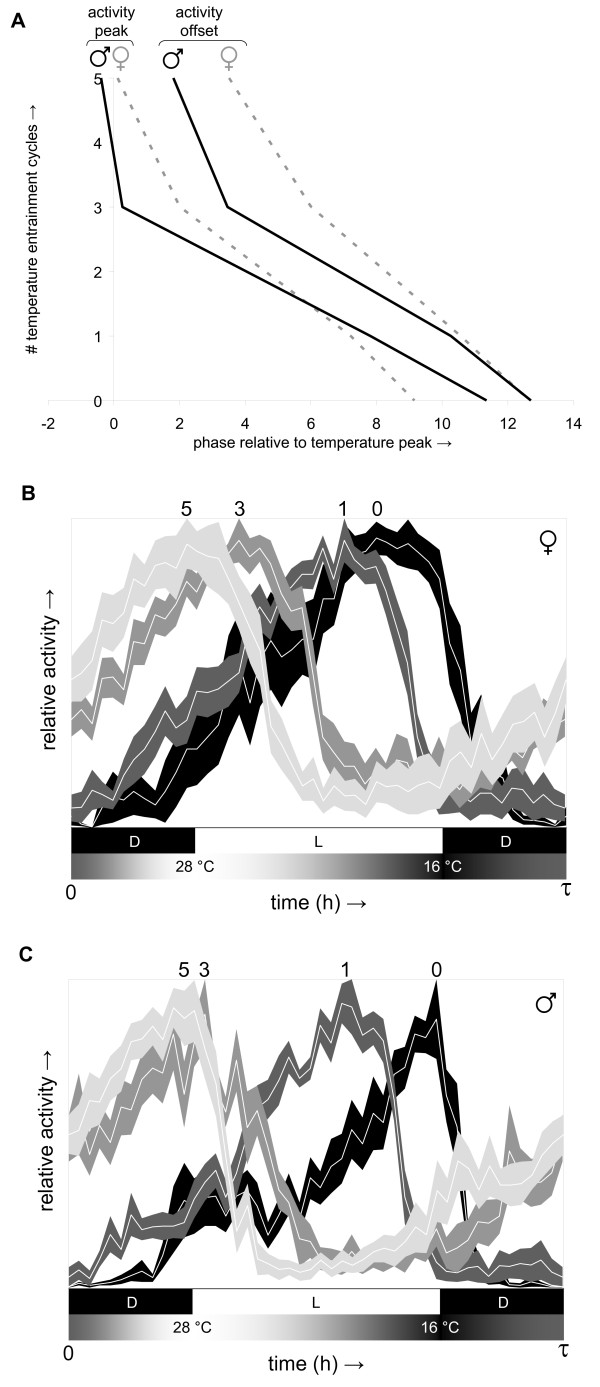
Phase resetting responses to daily temperature gradients are relatively slow and cumulative. After entrainment to 12-h dark/12-h light cycles (lights on from noon to midnight at constant 25°C for ≥4 days) groups of Canton-S male and female flies were exposed to 0, 1, 3, or 5 'anti-phase' daily temperature gradients (16°C at midnight to 28°C at noon to 16°C at midnight in constant darkness; see profile Z7T4C4 in Additional file 2) before being released into free running conditions at 25°C in constant darkness. The phase of peak and offset of activity during the free running circadian period length (τ) was determined from median activity records and plotted relative to the number of temperature cycles included in the experiment (A). The corresponding circadian activity profiles (mean ± S.E.M.) for female and male Canton-S flies are represented in panels (B) and (C), respectively, with individual experiments identified by the number of included temperature cycles (immediately above the peak) and increasingly lighter shades of gray. The shaded and black-and-white bars underneath the activity profiles represent the daily temperature gradient and light (L)/dark (D) treatments, respectively, used during previous entrainment.